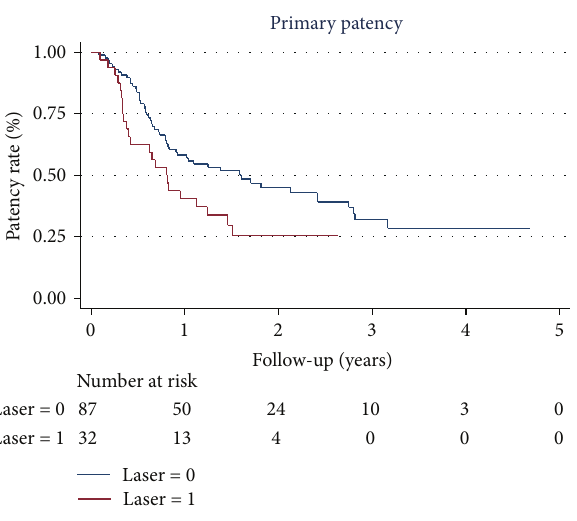
Figure 2: The Kaplan-Meier curve for primary patency. Laser 1 and laser 0 mean group A and group B, respectively.